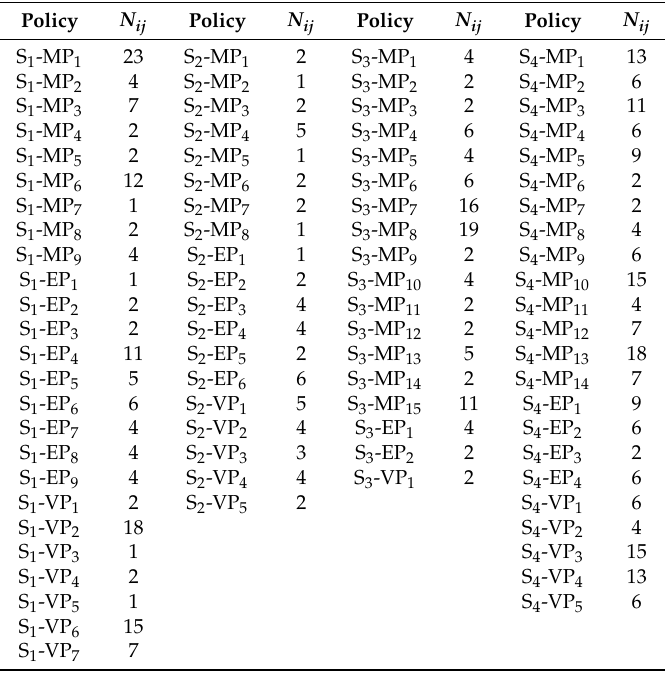
Table 11. Number of cities in applying emission reduction policies.